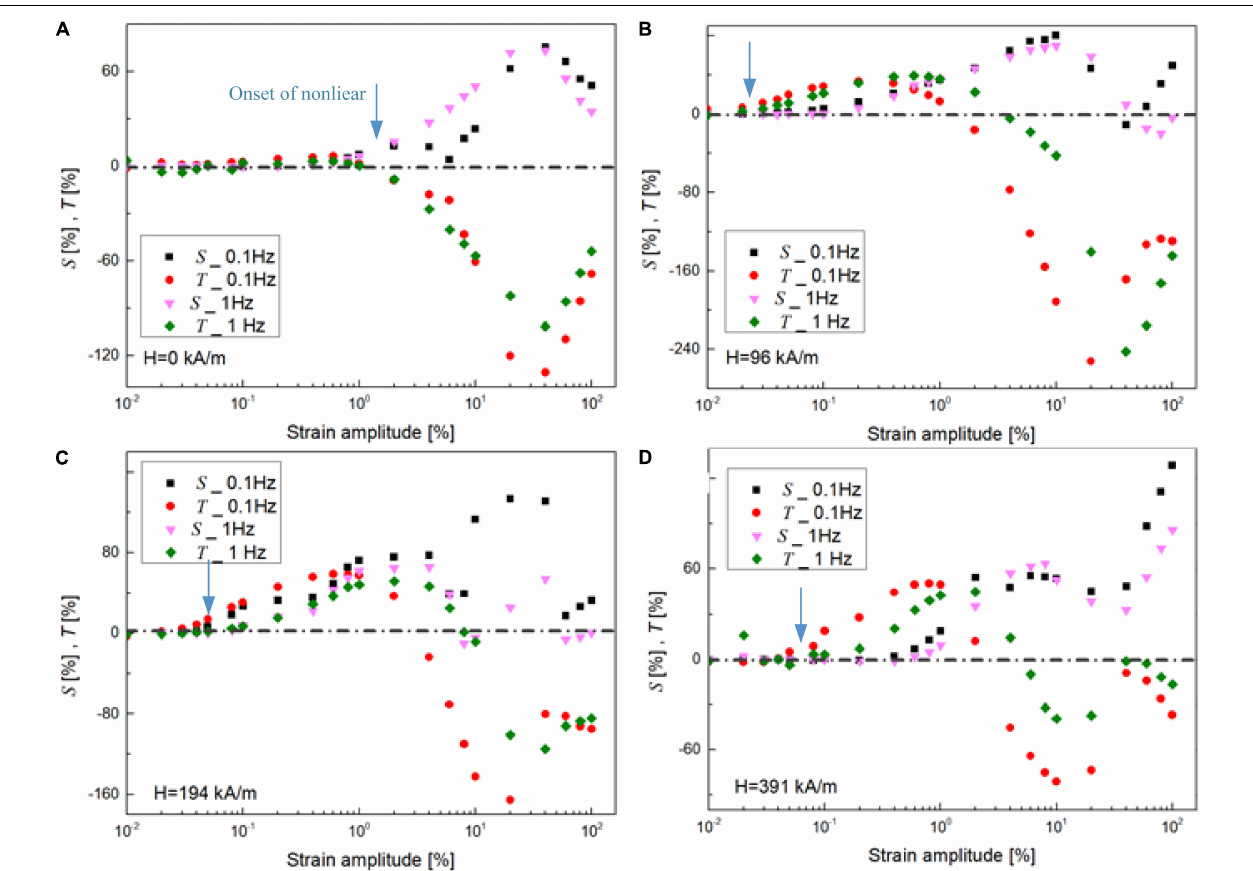
FIGURE 11 | Strain dependence of strain-stiffening ratio and shear-thickening ratio, i.e., S and T , for MRG-70 under different oscillatory frequencies, i.e., 0.1 and 1 Hz. The LAOS test was conducted on four different magnetic fields, such as (A) 0, (B) 96, (C) 194, and (D) 391 kA/m. The dashed lines indicate the value of zero. The blue arrow indicates the appearance of